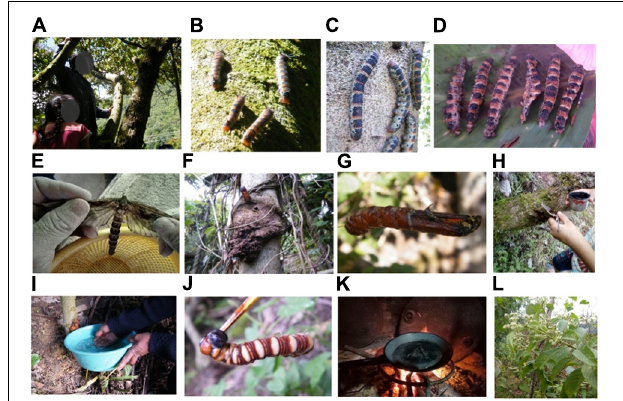
FIGURE 2 | Kuetlas , also called poxokuili , are collected from H. appendiculatus in the secondary vegetation and then relocated in a H. appendiculatus tree into the family home to be maintained under surveillance. (A) A girl and his grandfather supervise that a small group “manadita” recently collected climbs up the selected tree. At this stage, kuetlas had horns (B) , but the procedure can be also done with more mature kuetlas such as in (C) . (D) Kuetlas roasted by the girl’s grand-grandmother are ready to be eaten as a snack. Hepialidae gathering . After identification as “the mother,” an adult was released by a man in TC, with the intention of assuring the presence of this animal (E) . If the house or “little sponge” in host trees is intact, the worm must be present. Otherwise, the sponge will have holes or the molt left in the change from pupa to adult can be seen (F,G) . A girl in TC (H) and a woman in Sierra (I) show how to take out a “worm” from Lippia myriocephala and Fraxinus sp. (J) using water to drown it and, afterwards, using a spine to extract it when its head comes out. It must be done in silence since worms are very aware of the presence of predators. If they notice that a person is nearby, they will not come out. (K) Worms are fried with salt and eaten as a snack. (L) L. myriocephala